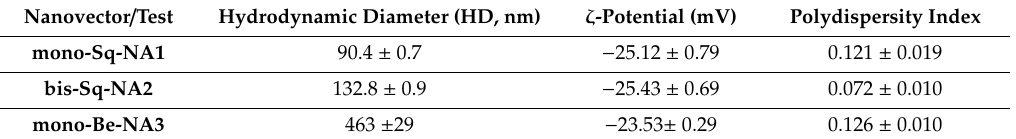
Table 1. Mono-Sq-NA1 , mono-Be-NA3 and bis-Sq-NA2 :